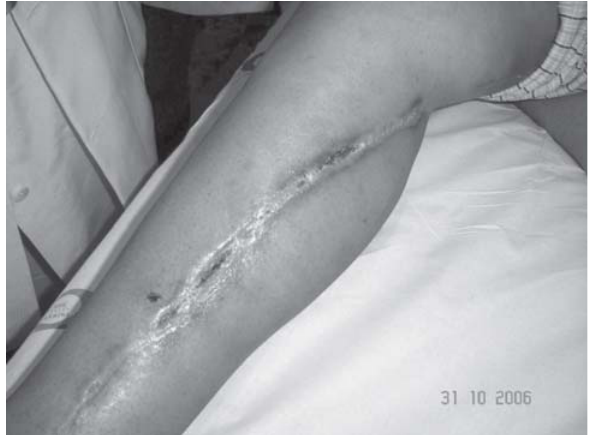
Fig. 3 - Deiscência da safenectomia: após a última aplicação do LBI